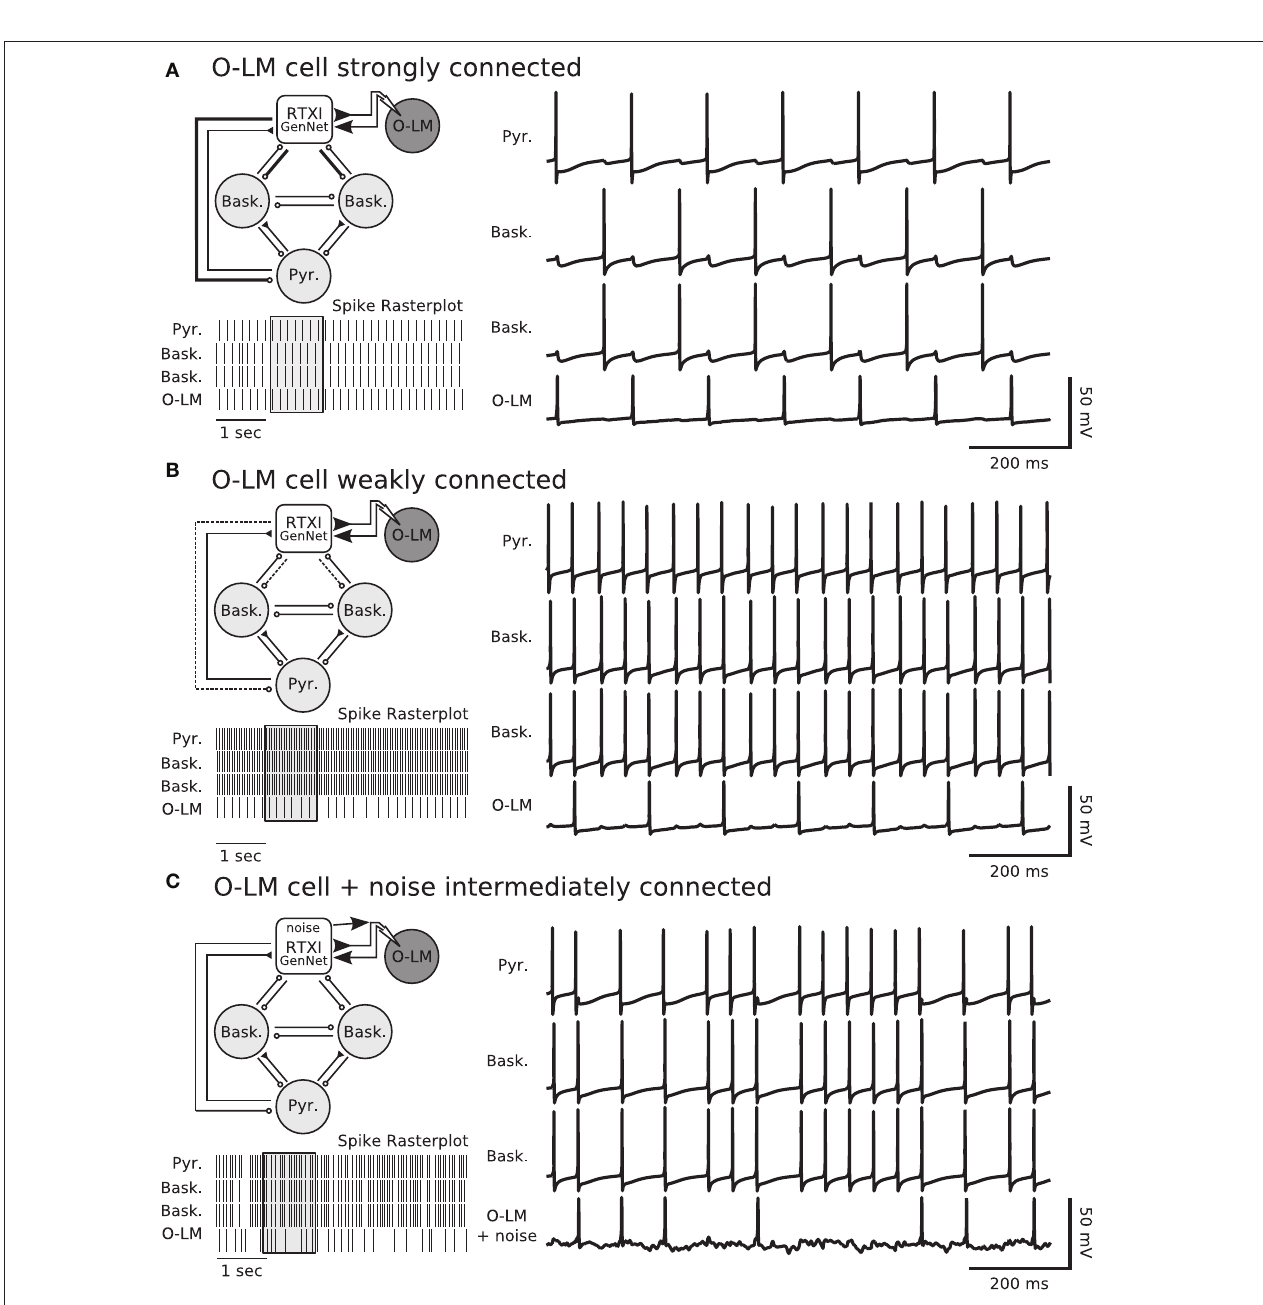
The voltage traces correspond to the region of the rasterplot in the shaded box. (B) Weak connectivity (dotted lines, top left panel) from the real O–LM cell to the rest of the simulated network results in an ongoing gamma rhythm (spike raster and voltage traces). Excitation from the pyramidal cells and subsequent rapid feedback inhibition forms a gamma rhythm between the pyramidal cell and the basket cells. Weak, theta-frequency inputs from the real O–LM cell are insufficient to prevent gamma frequency firing. (C) Hybrid network experiments performed with GenNet can be used in combination with existing RTXI protocols. The same hybrid network is run with synapses of intermediate strength (top left panel). In addition, RTXI is used to inject conductance noise into the real O–LM cell. Noisy drive combined with intermediate synapses results in a network in which O–LM spike times are variable and the network has periods of faster spiking interspersed with periods of slower spiking (top right panel and spike raster). The noisy voltage deflections in the O–LM cell due to noise injection are visible in its